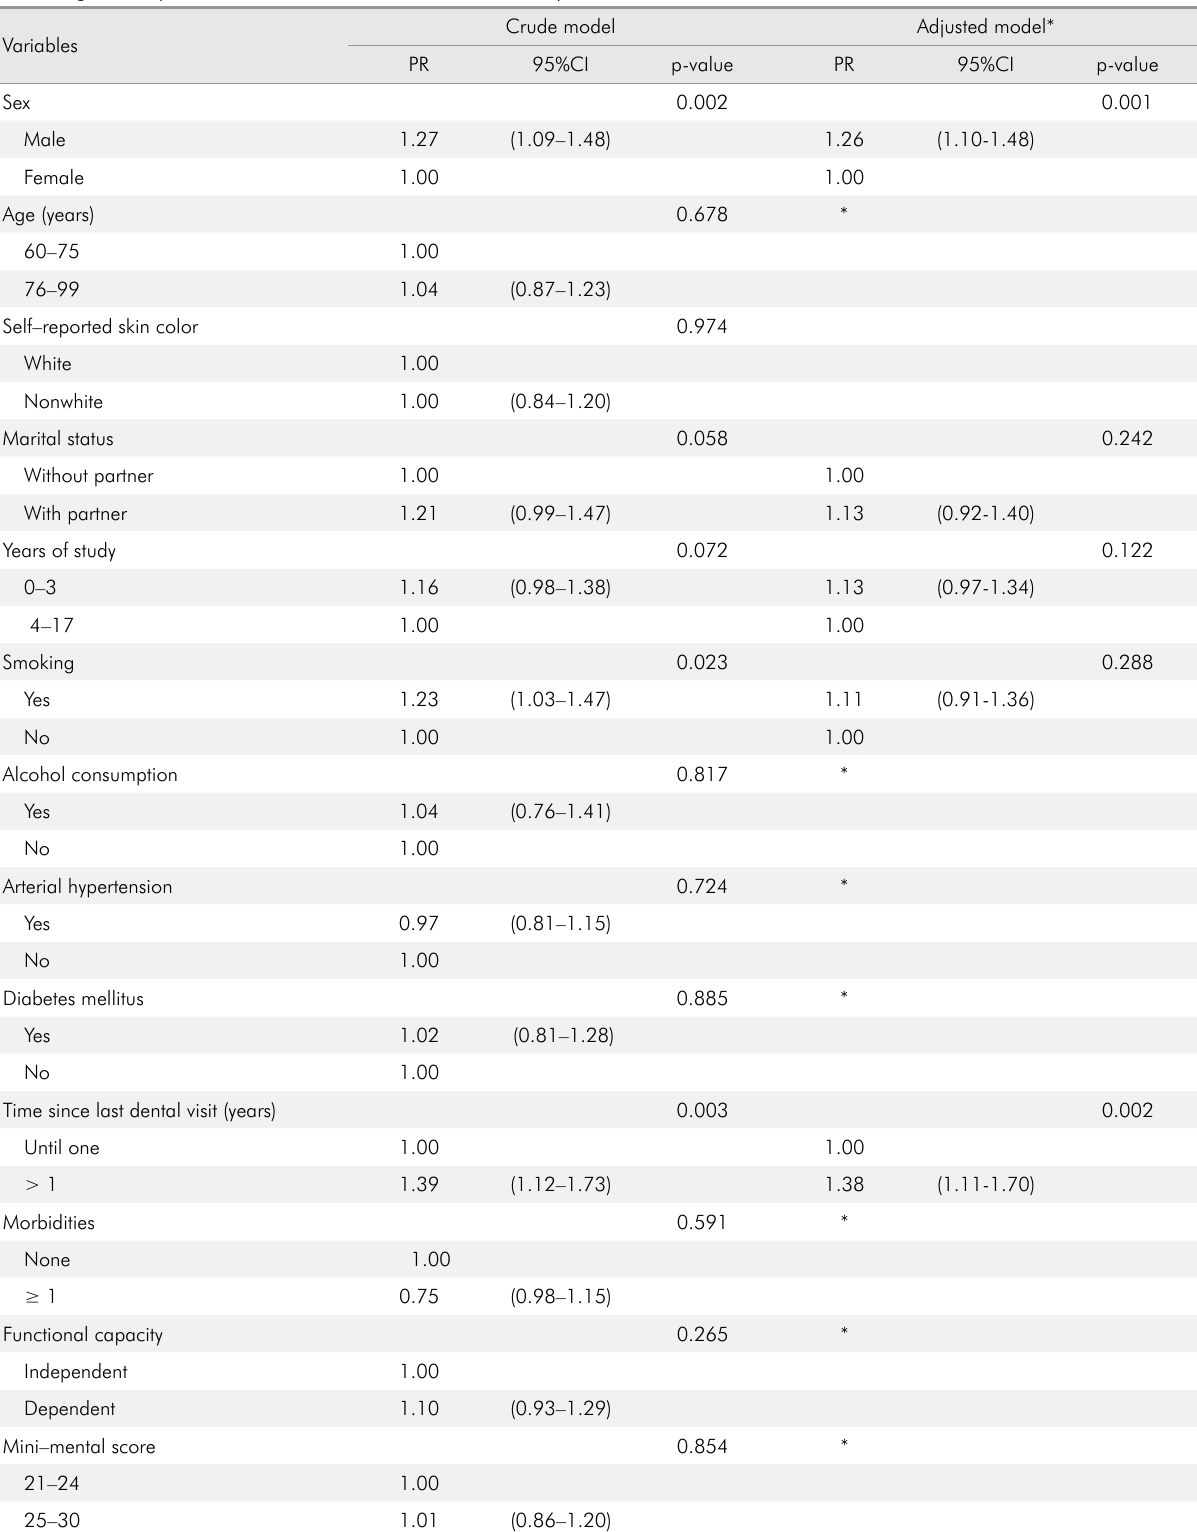
Table 2. Crude and Adjusted Prevalence (PR) and Confidence Intervals 95% (95% CI) of occurrence of need for dental prostheses according to independent variables in institutionalized